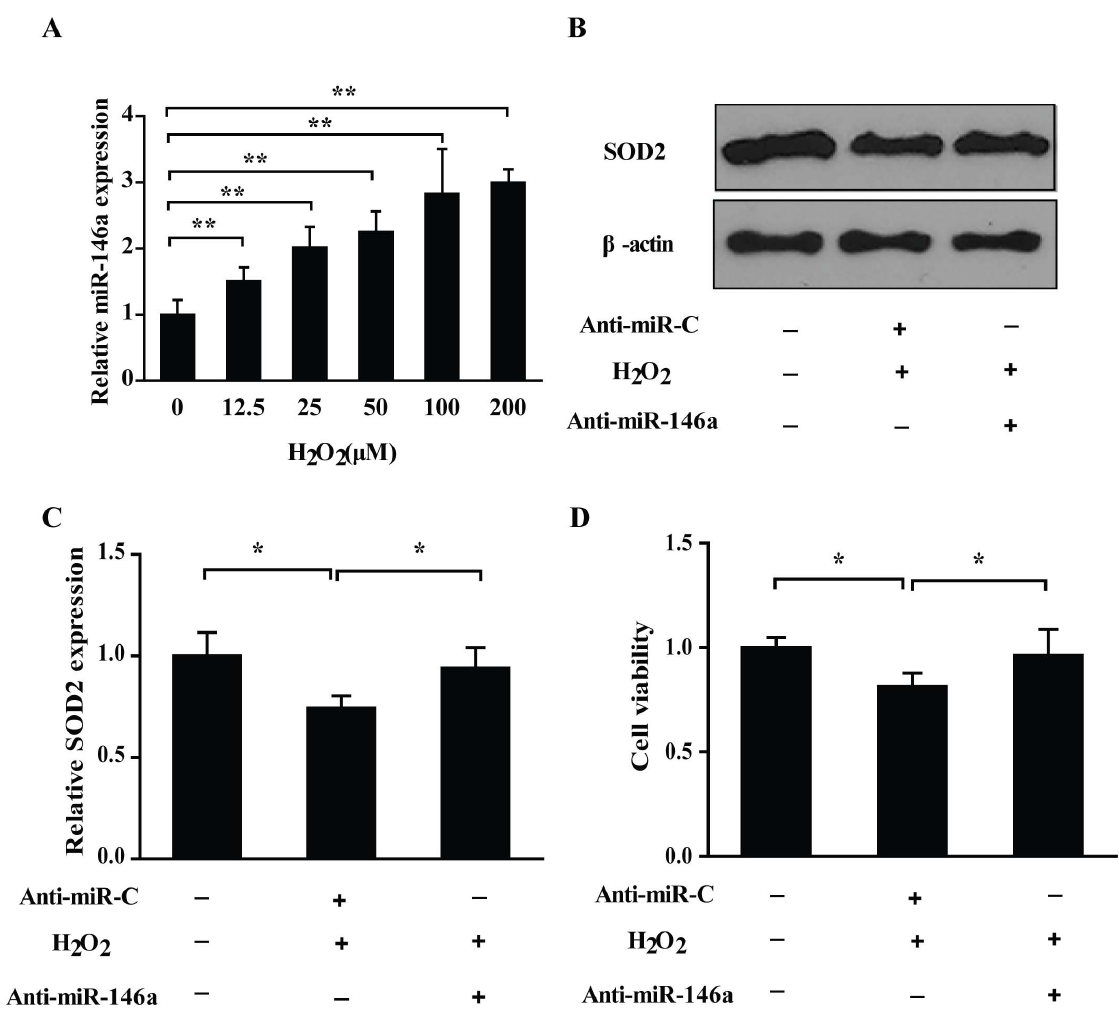
Figure 4. Identification of the regulatory role of miR-146a in the H 2 O 2 induced changes of SOD2 protein and PC12 cells viability. (A) H 2 O 2 increased the miR-146a expression in PC12 cells. Real-time RT-PCR revealed that H 2 O 2 enhanced the miR-146a relative expression level in a dose-dependent manner in PC12 cells after the stimulation with H 2 O 2 for 6 h. Data are shown the mean 6 SD (n=6), ** P , 0.01, as compared with control. (B) Down-regulation of SOD2 was reversed by antisense-miR-146a. PC12 cells were stimulated with 200 m M H 2 O 2 after a pretreatment with antisense-miR-146a for 24 h. Western blot assay showed antisense-miR-146a reversed the SOD2 protein decrease induced by H 2 O 2 . (C) The relative amounts of SOD2 protein are presented by the intensity ratio between SOD2 and b -actin in each lane. Data are shown the mean 6 SD from 3 independent experiments, * P , 0.05. (D) Antisense-miR-146a retrieved the decrease of PC12 cells viability induced by 200 m M H 2 O 2 . Data are shown the mean 6 SD (n=6), * P , 0.05.